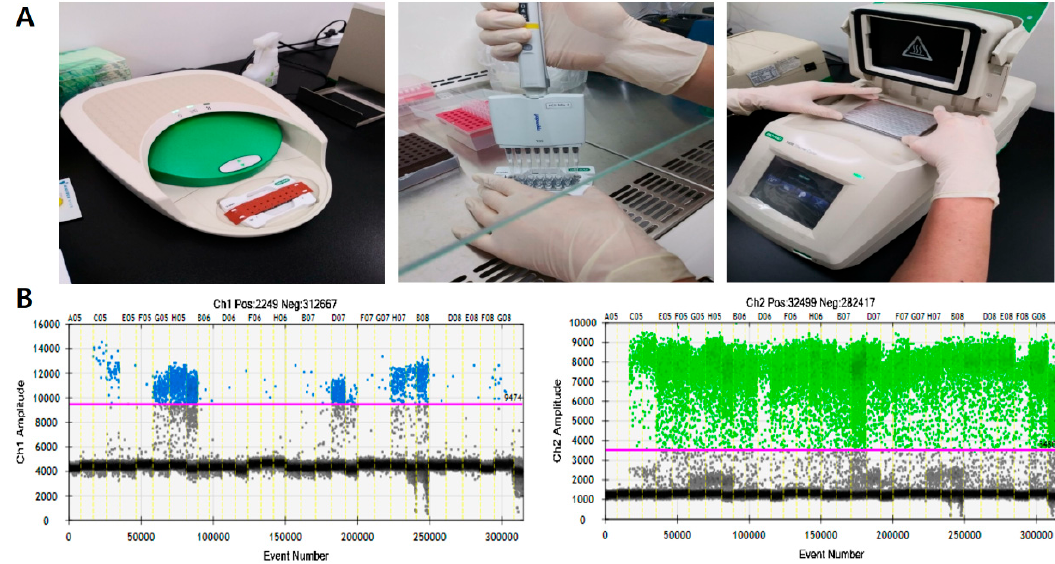
Figure 1. Droplet digital polymerase chain reaction (ddPCR) workflow ( A ) and representative results of ddPCR for detection of KRAS G12/13 . Channel 1: fluorescence measurement of mutant probe labeled with 6-fluorescein amidite (FAM). (( B ) left) Channel 2; wild-type probe labeled with hexachlorofluorescein (HEX) (( B ) right).